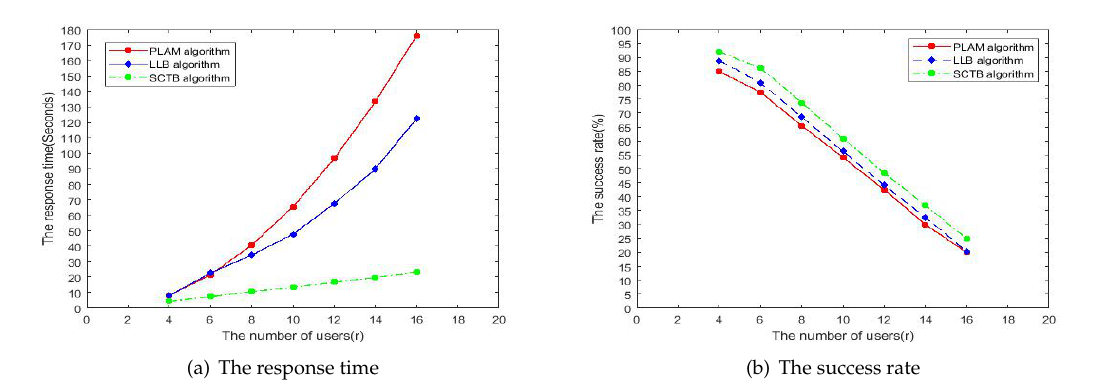
Figure 13. The simulation results for